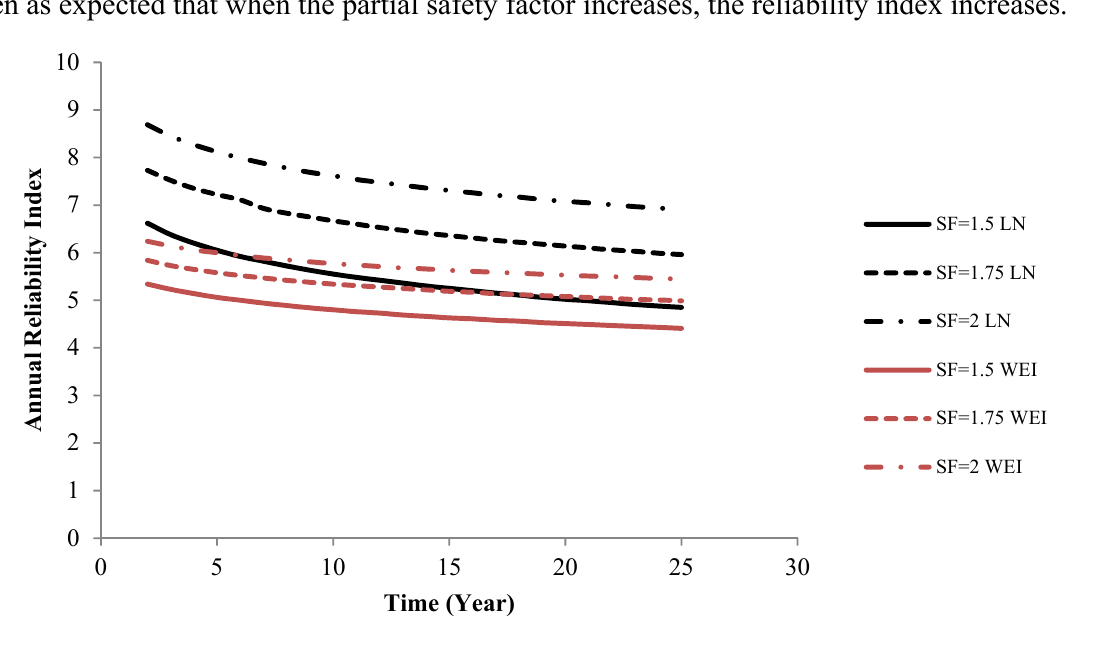
Figure 4. Annual reliability index for partial safety factor Weibull and log-normal models. Test D21 T95 R = −